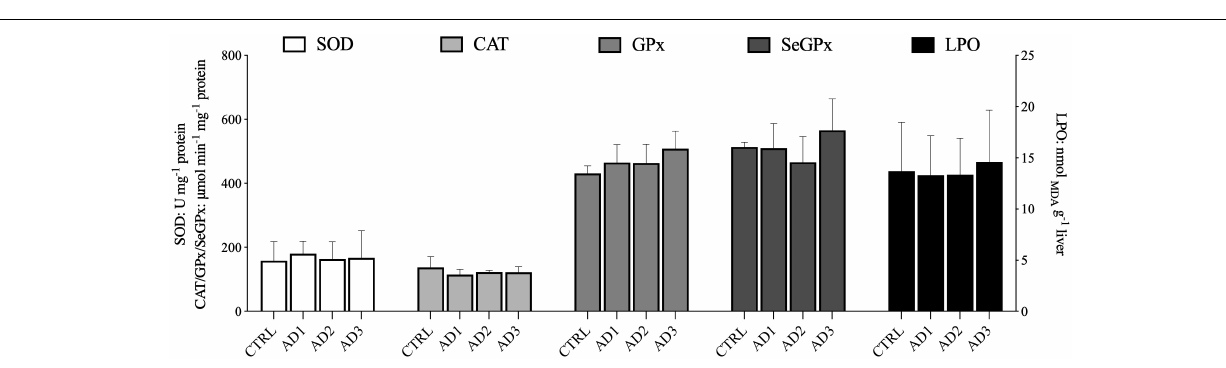
that only the highest incorporation of L. digitata (0.8%) in